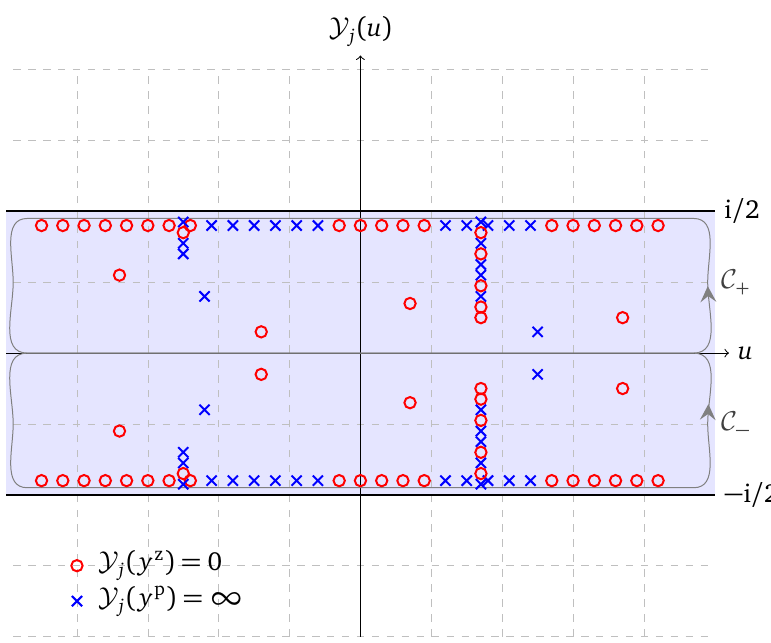
Figure 4: Schematic depiction of the analytic data for a typical meromorphic Y - function associated with the dominant eigenvalue of the fundamental column trans- ( u ) at finite N . The analytic data comprises zeros (red circles) and fer matrix T 1 poles (blue crosses) in the complex strip P . The integration contours C + and C − , encircling the upper and lower halves of the physical strip P , are separated from the lines u = ± i by the regulator ε . The contributions from the regularised node data 2 (cid:12) ( ± ) ( ± ) λ = (cid:12) (cid:12) Λ ( ± ) from the lines u = ± i appear separated by distance ξ . The (cid:12) / 2 π n j 2 j j j analytic data lie within the contours C ± , with clusters of zeros and poles appearing as Padé approximants of non- integer branch